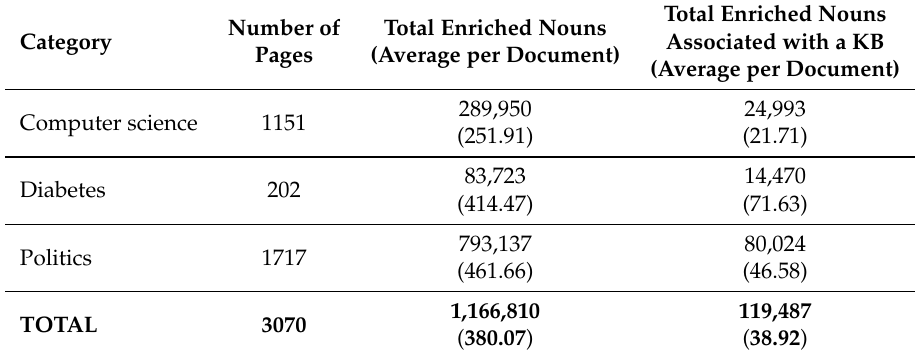
Table 3. Category information per topic and enriched noun extraction